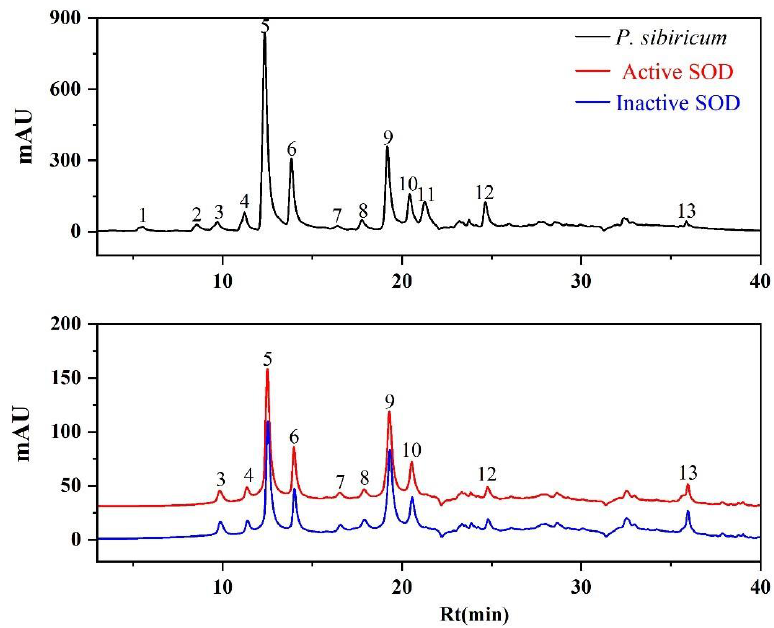
Figure 2. The UF-LC-UV chromatograms of the EA fraction from P. sibiricum with superoxide dismutase (SOD) at 280 nm. The black line represents the UPLC profiles of EA fraction, the red and blue line represent activate and inactivate SOD,